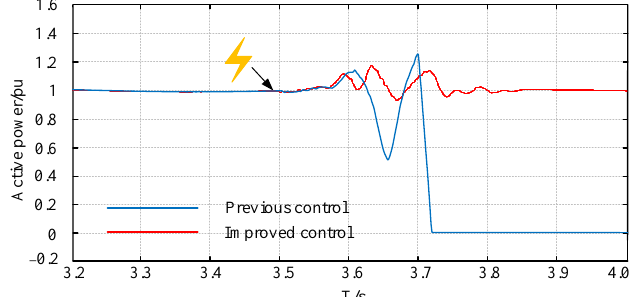
Figure 12. The active power of the Hornsea 1B.